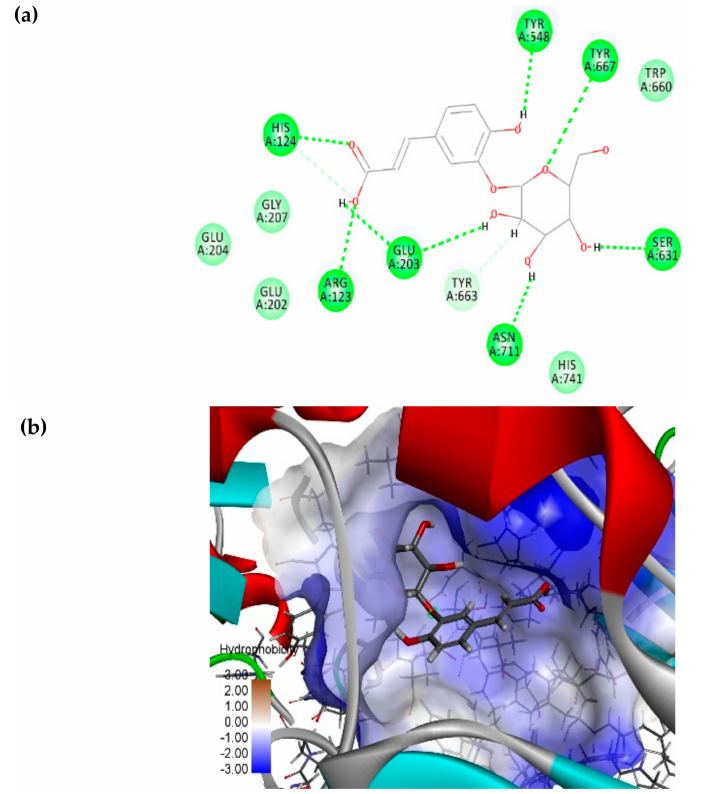
Figure 8. Phytochemical ca ff eic acid 3-glucoside bound structure on the DPP-4 druggable region with active site residues interacting analysis. ( a ) Two-dimensional interaction analysis, ( b ) binding pose